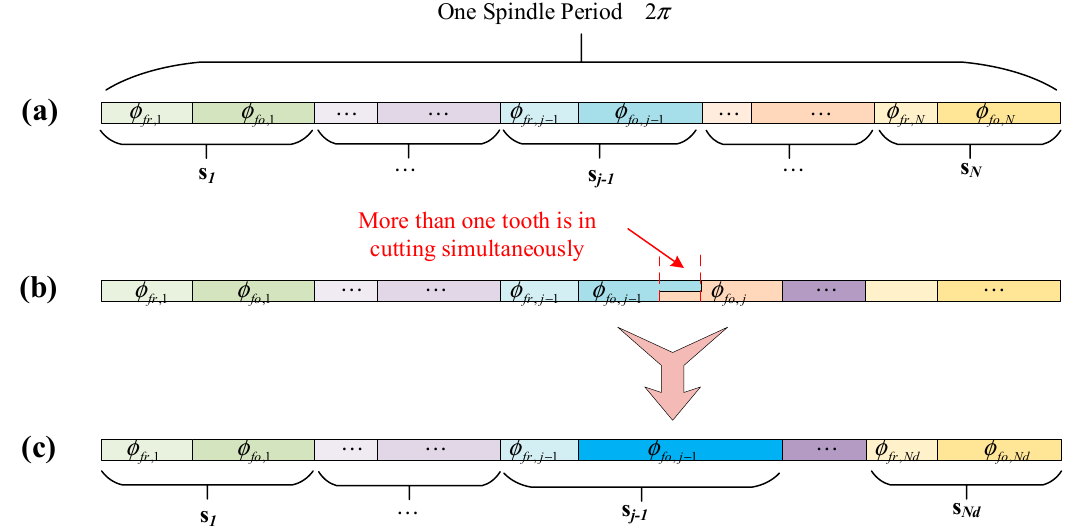
Figure 2. The distribution of free vibration and forced vibration angle interval in one spindle period, ( a ) at most one tooth is in cutting; ( b ) more than one tooth is in cutting simultaneously; ( c ) combine the continuous forced vibration angle interval.